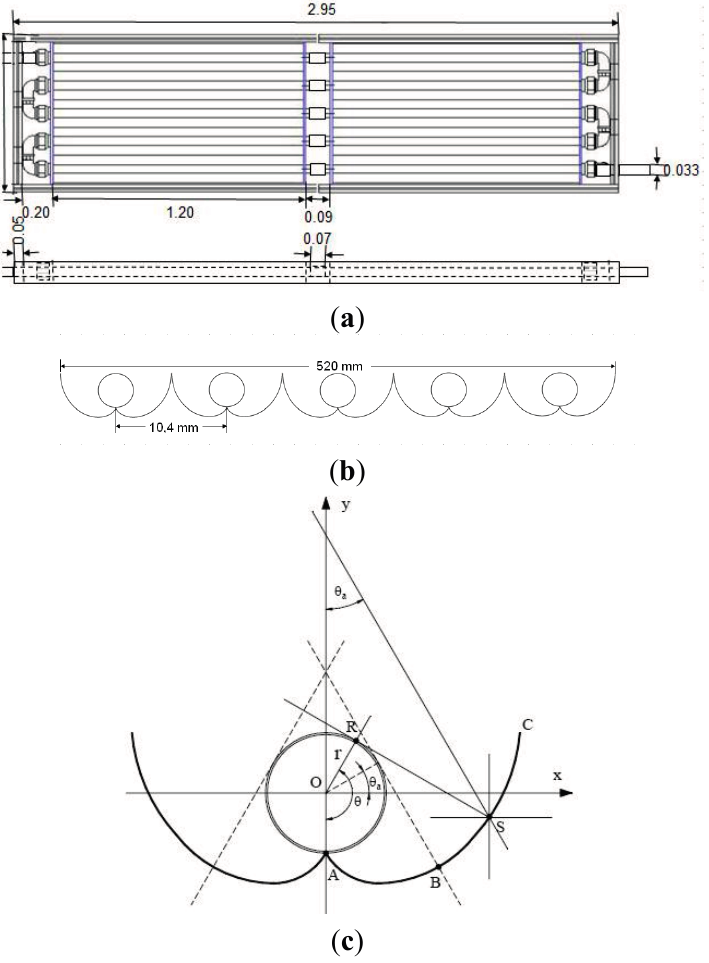
Figure 13. Solar CPC Photoreactor details: ( a ) superior and lateral views and ( b ) frontal view showing the curvature of the compound parabolic collectors; ( c ) CPC involute